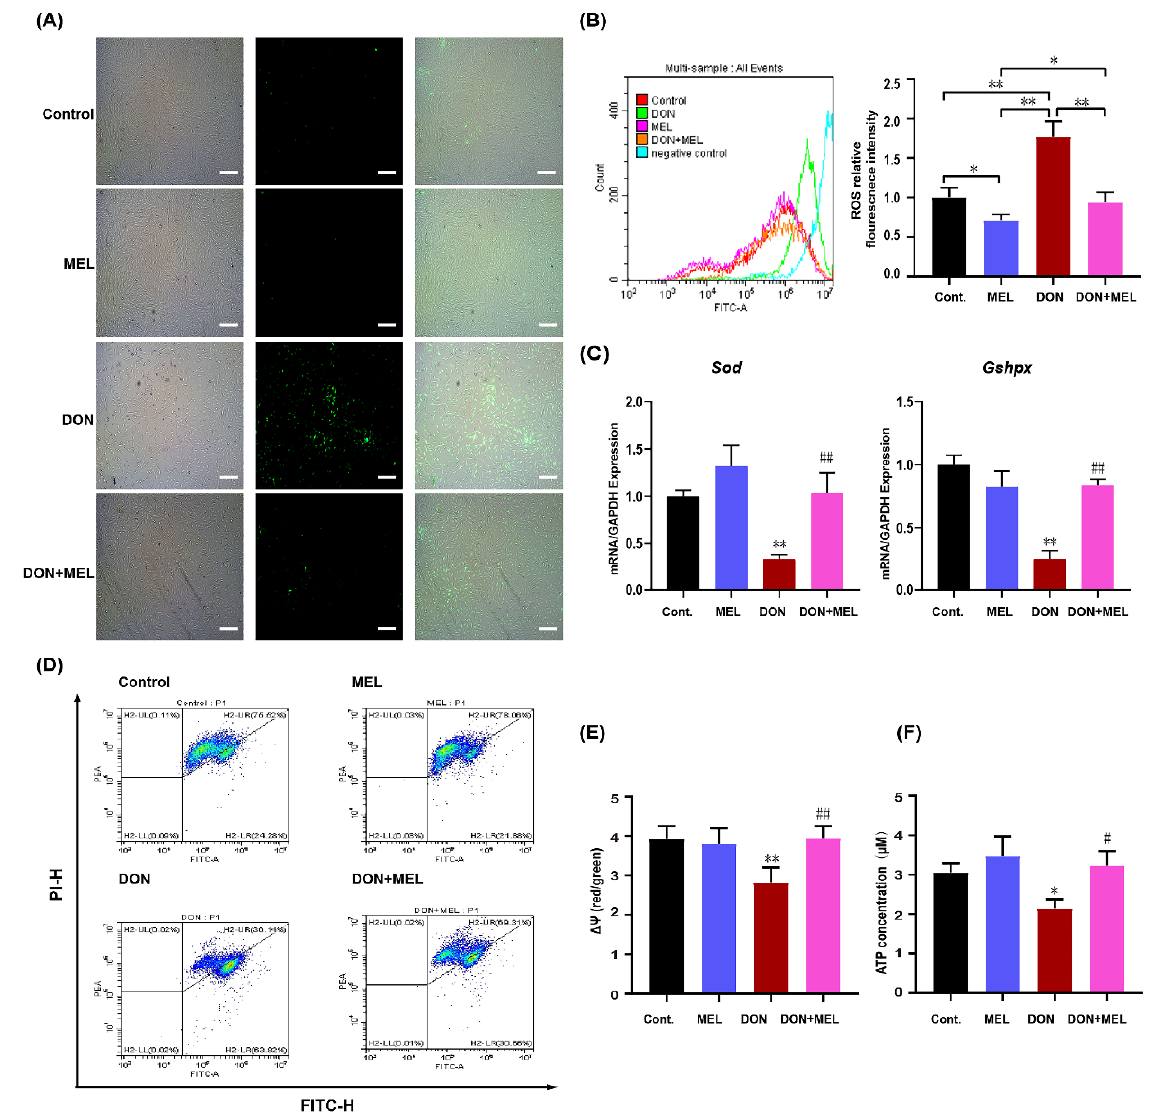
Figure 3. Effects of melatonin on ROS levels and mitochondrial function of murine ovary GCs upon DON exposure. ( A ) Representative images of ROS levels in the control, melatonin (MEL)-exposed, DON-exposed, and MEL + DON-treated mouse ovary GCs. Scale bar, 300 µm; ( B ) Fluorescence intensities of ROS in the mouse ovary GCs of the different groups; ( C ), qRT-PCR analysis of the relative expression of Sod and Gshpx mRNA levels. ( D ) Mitochondrial membrane potential levels of the different groups. ( E ) The ratio of the red over green fluorescence intensity by flow cytometry represents the quantitative Δ Ψ m in each group. ( F ) ATP content of the different groups. All values are expressed as the means ± SD ( n = 3), * p < 0.05 and ** p < 0.01 versus the control group; # p < 0.05 and ## p < 0.01 versus the DON group. MEL: melatonin.